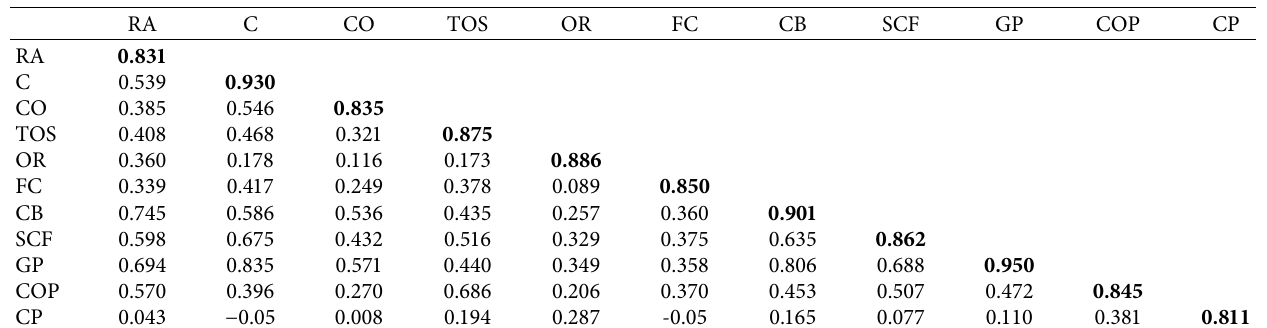
Table 9: Interconstruct correlation (discriminant validity) for public construction